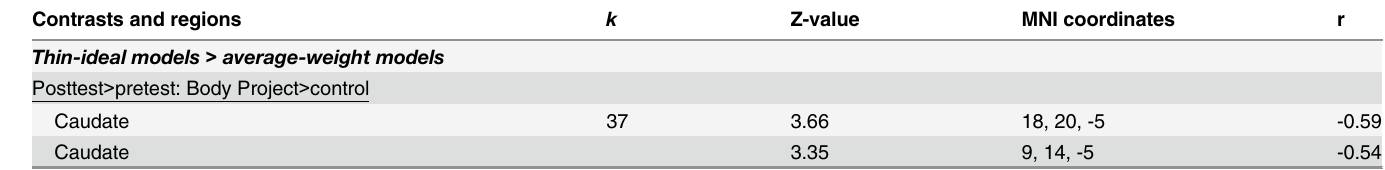
Table 2. Significant Time-by-Group Interactions in Brain Activation during Thin-Ideal Models vs Average-Weight Models. Contrasts and